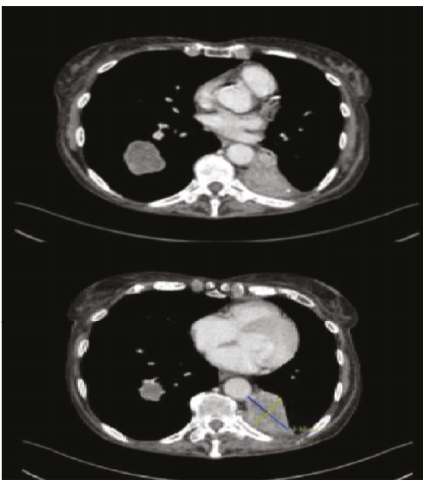
Figure 1: Restaging CT prior to Nivolumab. Image on the top shows the RLL at its largest diameter and the image on the bottom shows the LLL at its largest diameter.